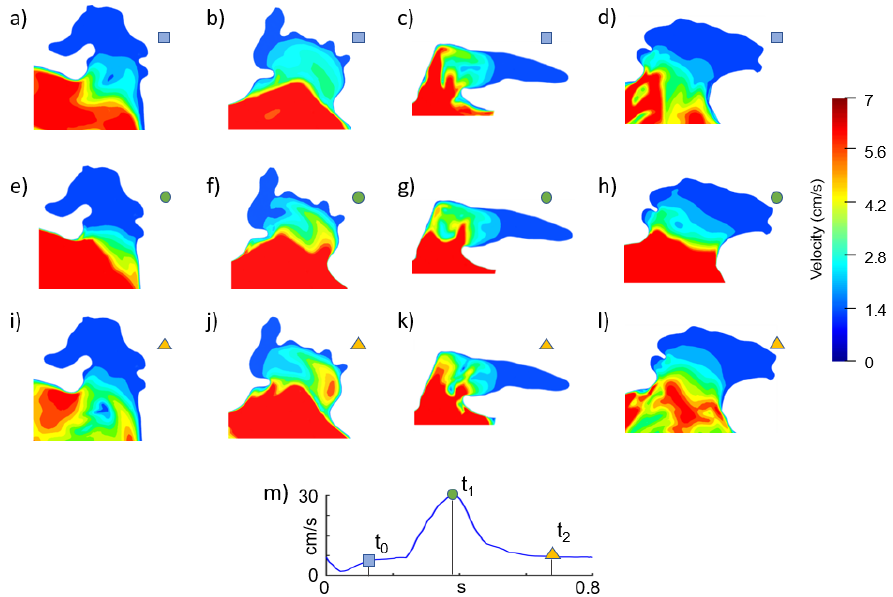
Figure 7. Velocity fields of the four LAA shapes, i.e., CW ( a , e , i ), CF ( b , f , j ), WS ( c,g,k ) and CS ( d , h , l ) at t 0 time ( a – d ), t 1 time ( e – h ) and t 2 time ( i – l ) of the cardiac cycle in terms of MV velocity profile ( m ).